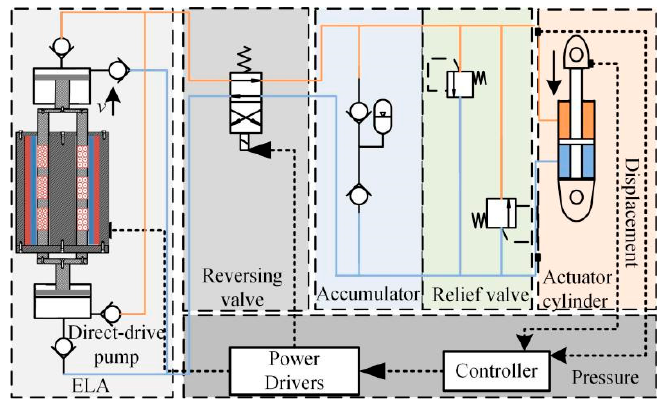
Figure 1. Schematic diagram of EDHAS.